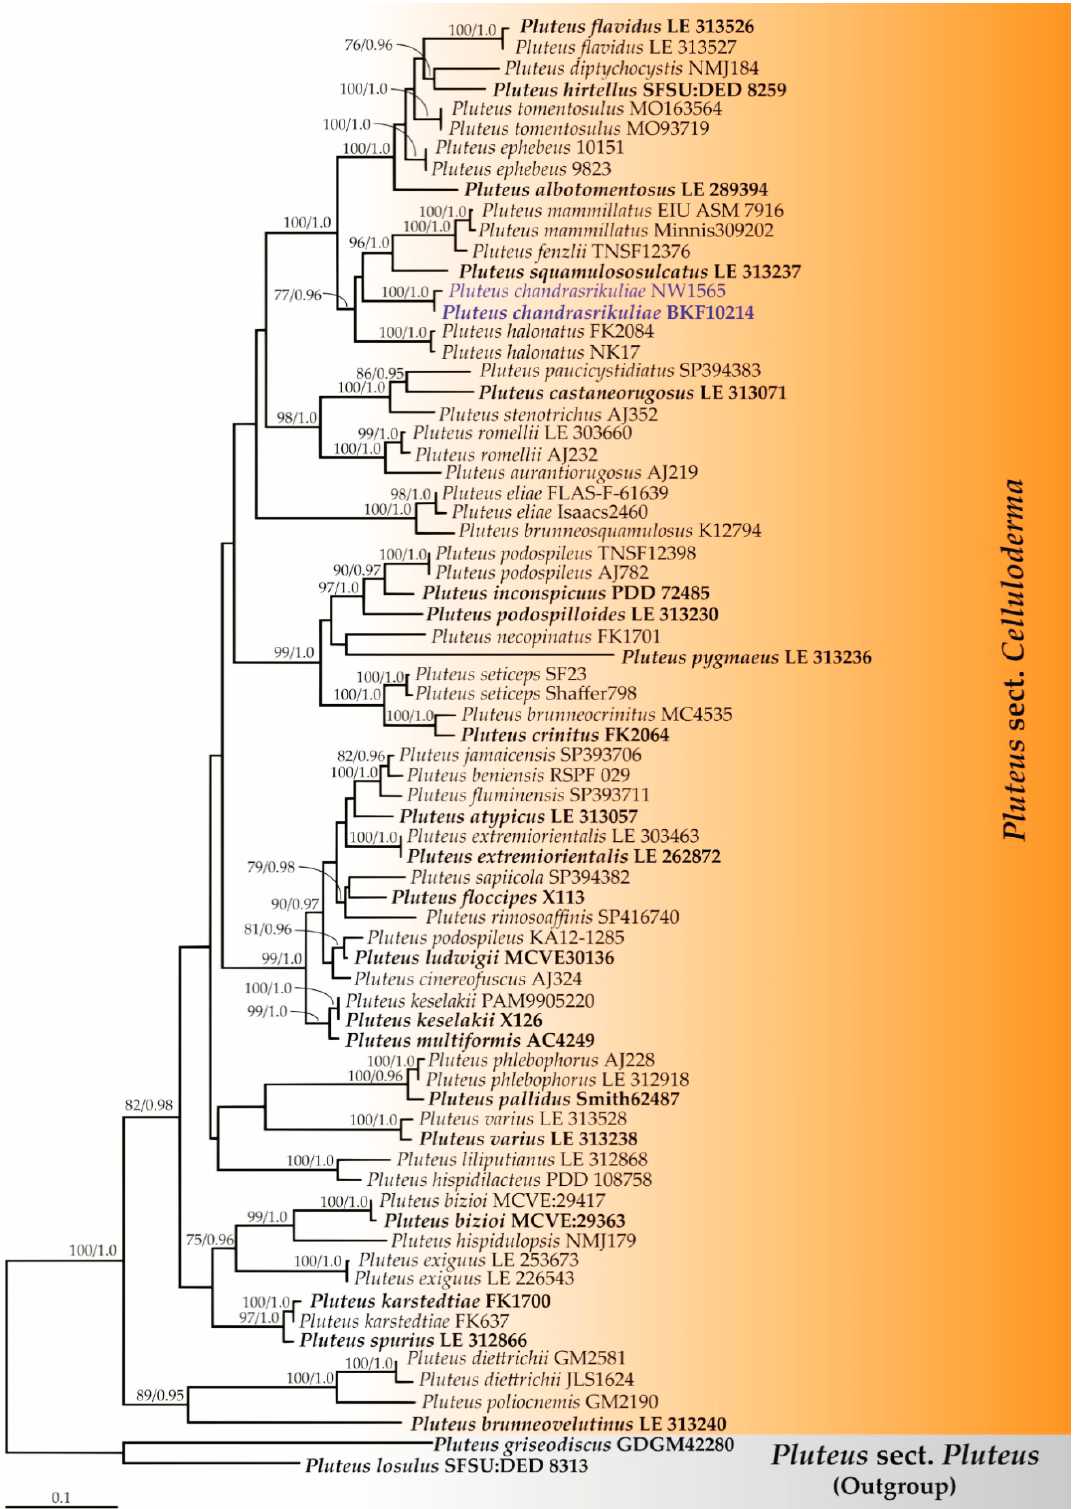
Figure 1. Phylogram derived from maximum likelihood analysis of Pluteus sect. Celluloderma consists of 72 taxa of ITS sequences. Pluteus griseodiscus and P. losulus were used as the outgroup. The numbers above branches represent bootstrap percentages ( left ) and Bayesian posterior probabilities ( right ). Bootstrap values ≥ 75% and Bayesian posterior probabilities ≥ 0.90 are shown. The scale bar represents the expected number of nucleotide substitutions per site. Sequences obtained from this study are in blue. Type specimens are in bold.